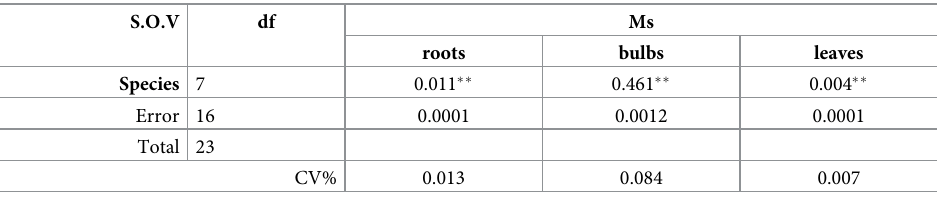
Table 2. ANOVA for allicin contents in Allium